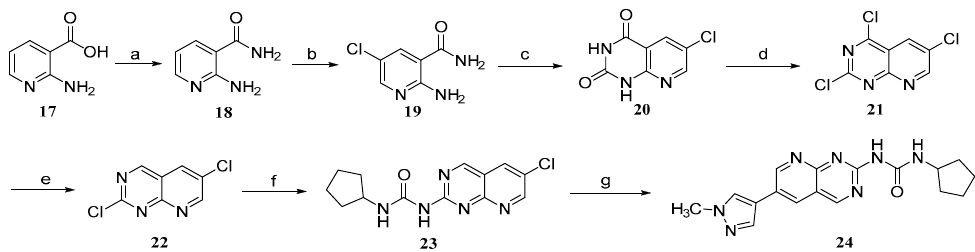
Molecules 2020 , 25 , x 5 of 23 Figure 5. Design of our ERK/PI3K dual from 1 H -pyrazolo[4,3- c ]pyridine to pyrido[3,2- d ]pyrimidine scaffold . 2.2. Chemistry The synthetic routes of all target compounds are outlined in Schemes 1–4, respectively. Compounds 16a ~ 16d were synthesized using the synthetic route as shown in Scheme 1. Starting materials 7 was transformed into aldehyde 8 via Bouveault reaction. The resulting aldehyde 8 reacted with hydrazine hydrate to afford the cyclization intermediate 9 followed by reacting with NIS to gain the iodine intermediate 10 . TrtCl was added to protect the pyrazole N atom, and then 11 underwent the Suzuki C-C coupling reaction and Buchwald C-N coupling reaction to produce the intermediates 15a ~1 5d . After removing protect group Trt in the presence of F 3 CCO 2 H in DCM at room temperature (r.t) for 12 h, target compounds 16a ~ 16d were obtained. Scheme 1. Preparation of target compounds 16a ~ 16d . Reagents and conditions: ( a ) 1.3 M i-